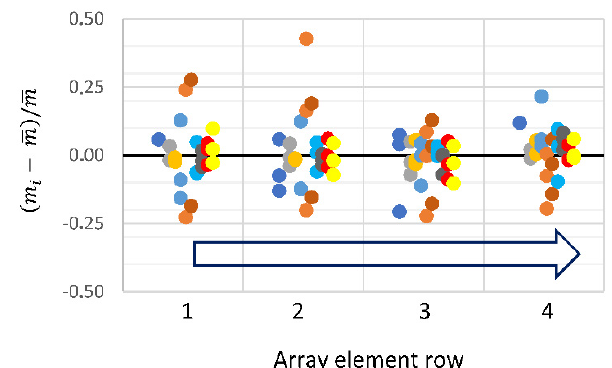
Figure 5. Variation in the adsorbed mass as a function of the sensor position. The absolute deviation of the adsorbed mass, normalized by the mean, is plotted against the row of the array element. m i is the adsorbed mass detected by the i-th element of the array (see Figure S1). m is the average mass in a given column. Different colors represent different experiments. Results of each individual experiment are offset from each other for visibility. Blue open arrow indicates the direction of the fluidic flow up the column.